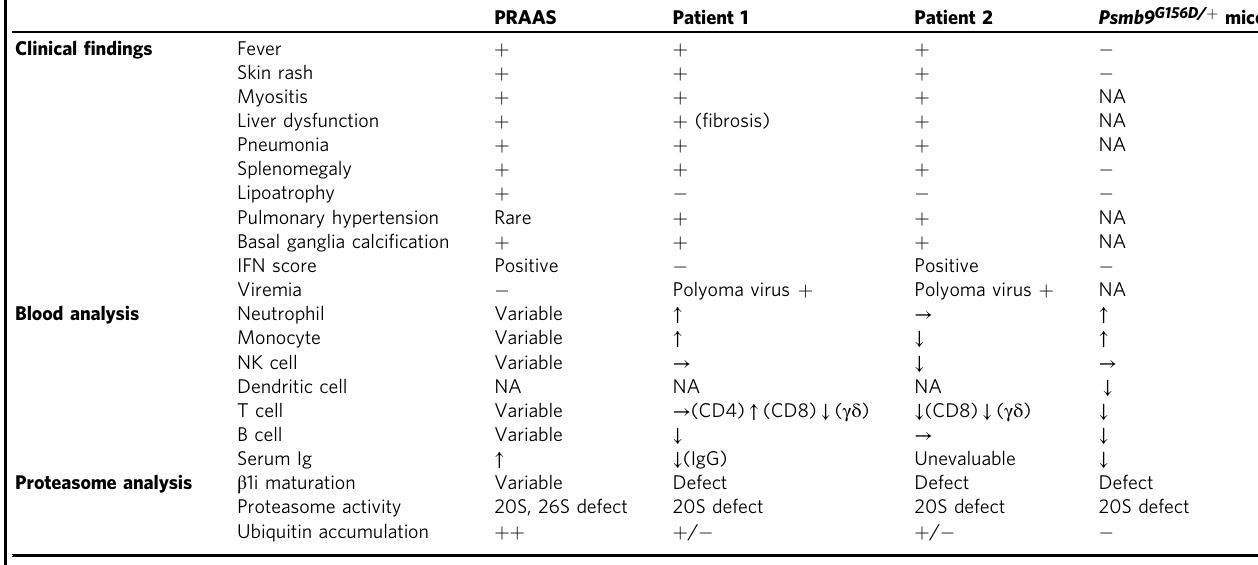
Table 1 Comparison of PRAAS, patients 1, patient 2, and Psmb9 G156D/ +